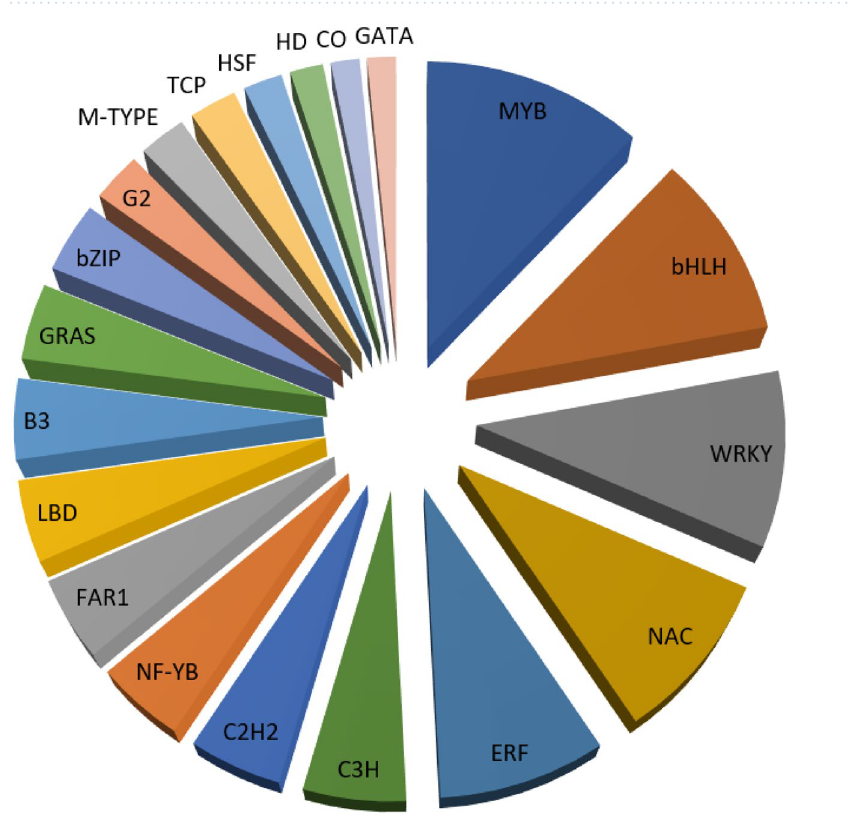
Figure 7. The first twenty transcription factors (TFs) identified in the